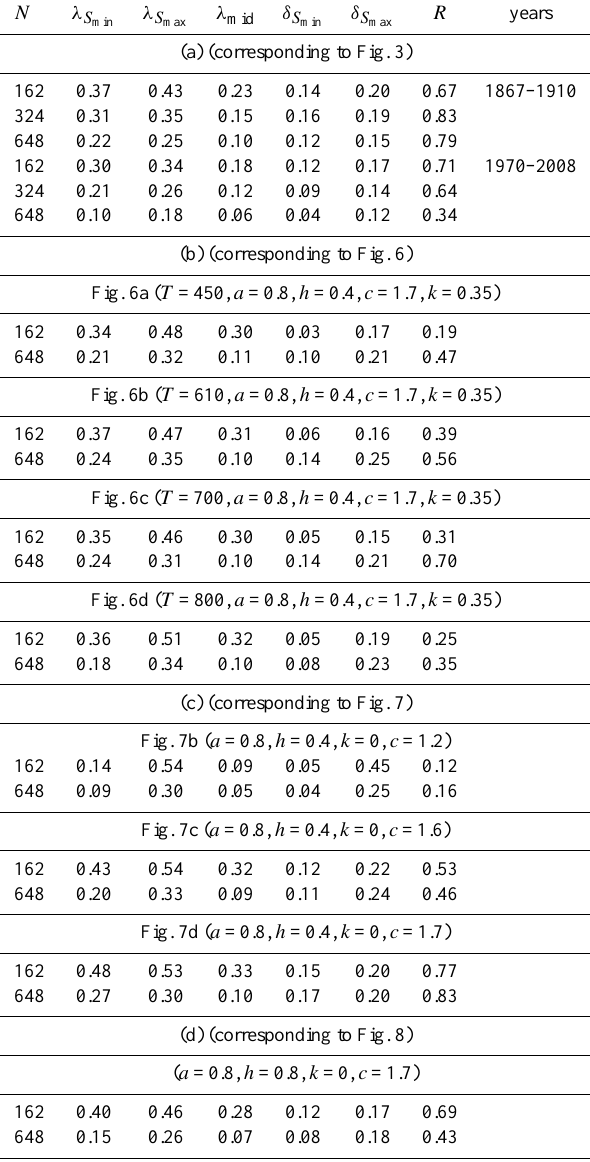
Table 1. Calculation of R ratio values (see text). N is the number of days over which the ISSN data are smoothed to remove in particu- lar the effect of solar rotation; λ S is the mean value of the max- min ima of the irregularity index at the times of solar minima over the period range indicated under the heading “years” (by default 1867– 2008 when not indicated); λ S is the mean value of the maxima max of the irregularity index at the times of solar maxima over the same period range; λ mid is the mean value of the minima of the irregu- − λ larity index as indicated in Fig. 2 in the text; δ S = λ S mid ; min min